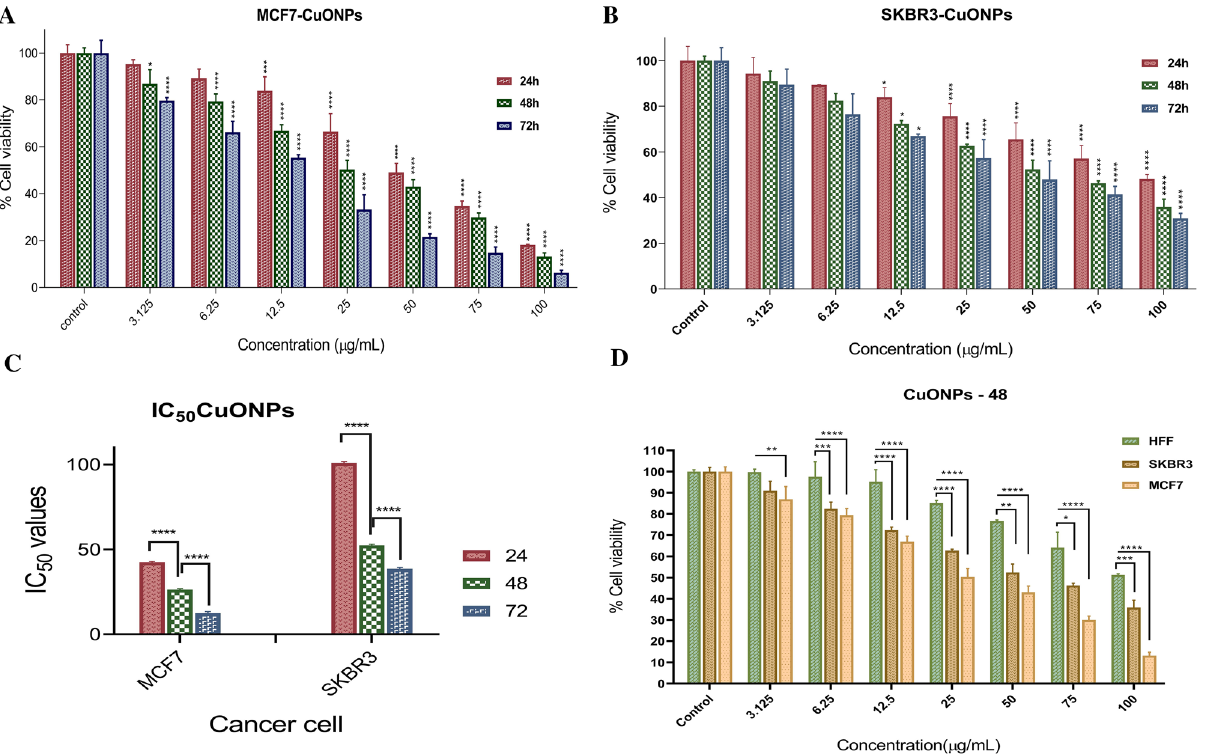
Figure 5. Different concentration cytotoxicity of BC-CuONPs against ( A ) MCF7, ( B ) SKBR3 for 24, 48, and 72 h. ( C ) IC 50 concentration of BC-CuONPs against MCF7 and SKBR3 cells. ( D ) Comparison of CuONPs- induced cell cytotoxicity in HFF, SKBR3, and MCF7 cell lines after 48 h treatment. (*: P < 0.05, **: P < 0.01, ***: P < 0.001, and ****: P <